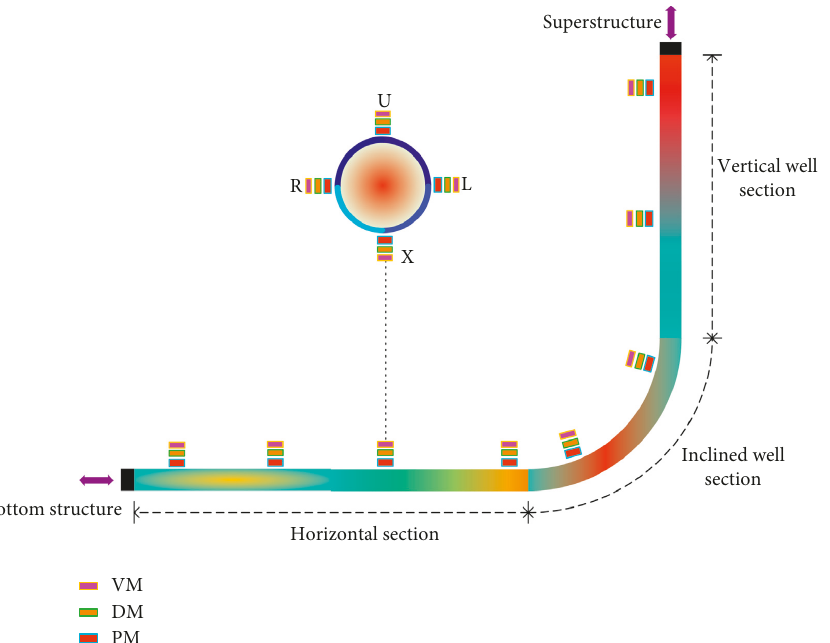
Figure 10: Gas storage nonlinear vibration measurement point data element